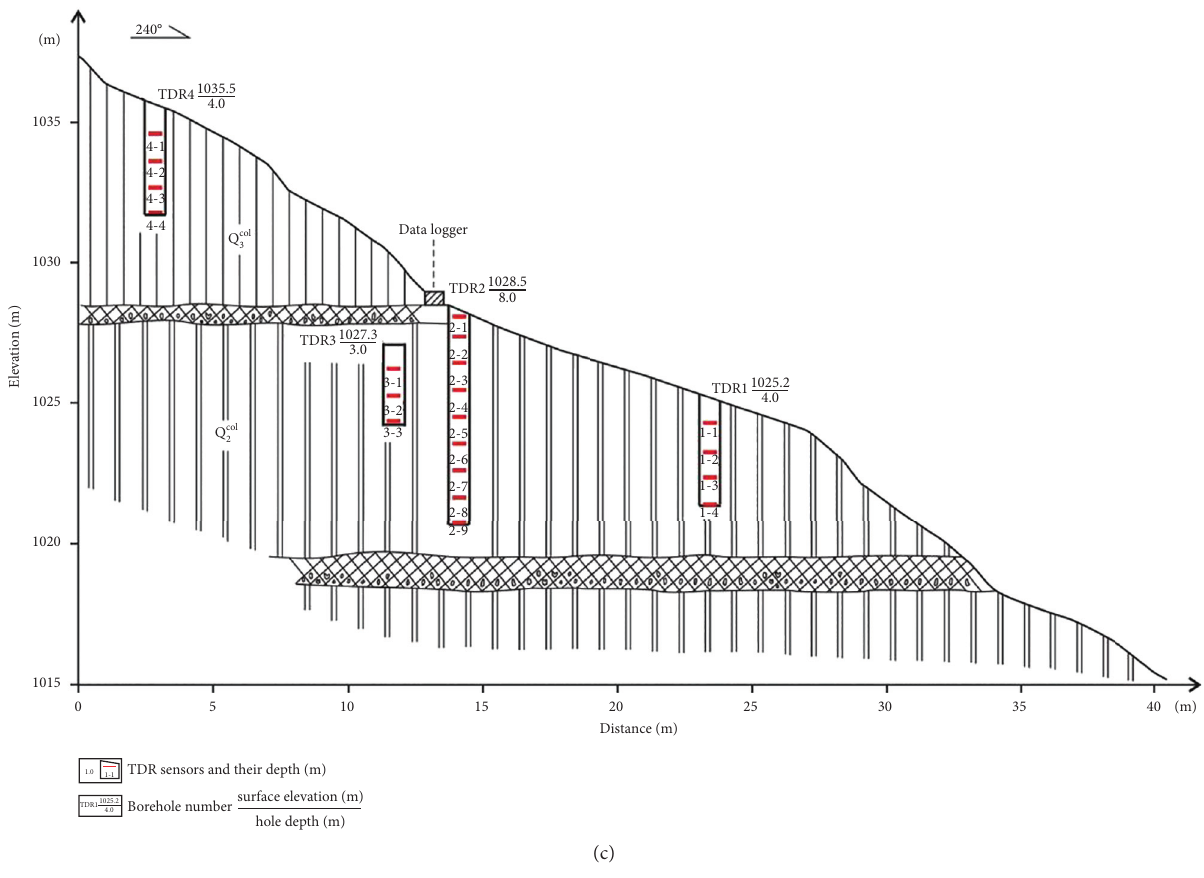
Figure 2: Schematic of monitoring system in Baota Mountain landslide and vertical section of boreholes with monitoring sensors: (a) schematic of monitoring system in Baota Mountain landslide; (b) distribution of ZK; (c) distribution of Table 1: Parameters for landslide No. 1 and landslide No. 2.